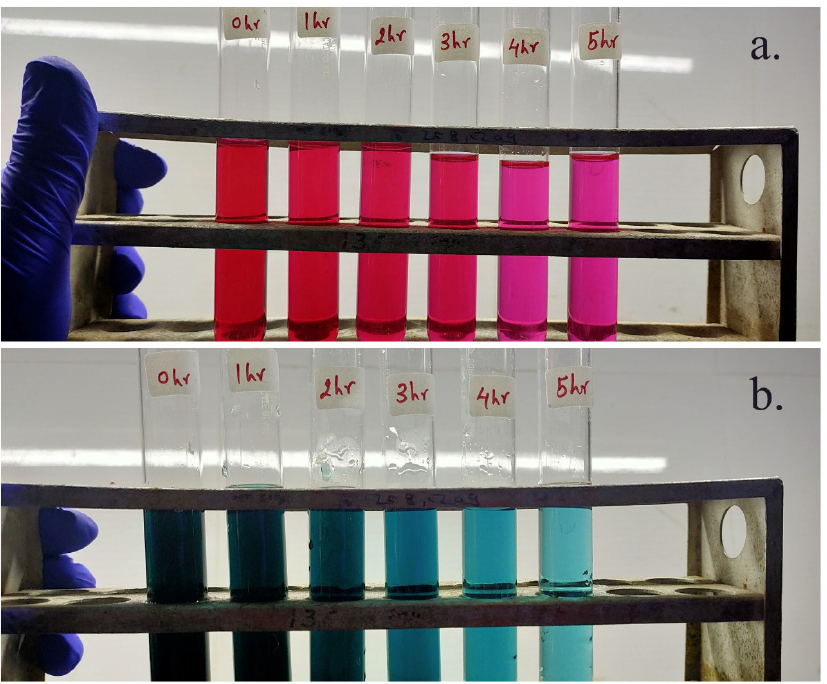
Fig. 16. Dye degradation at different Time Intervals a) Red M8B, b) Reactive